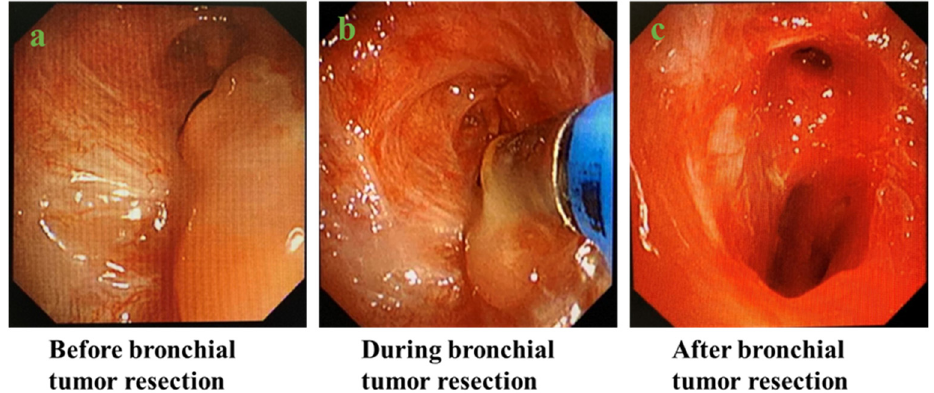
Figure 1. Process of endobronchial tumor resection under rigid bronchoscopy: ( a ) before bronchial tumor resection; ( b ) during bronchial tumor resection; ( c ) after bronchial tumor resection.